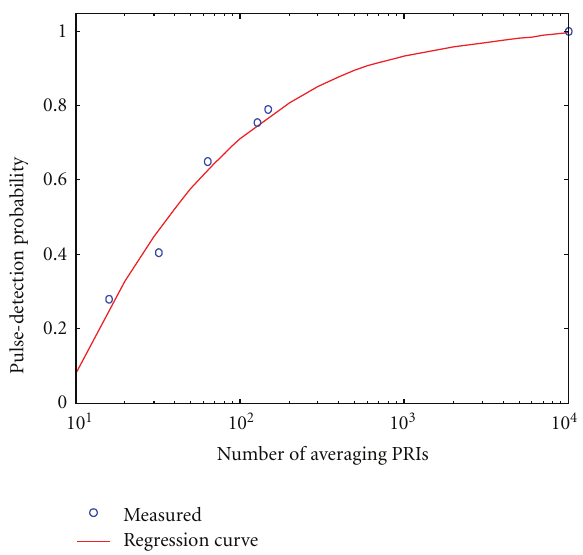
Figure 15: Pulse-detection probability versus number of averaging PRIs in outdoor